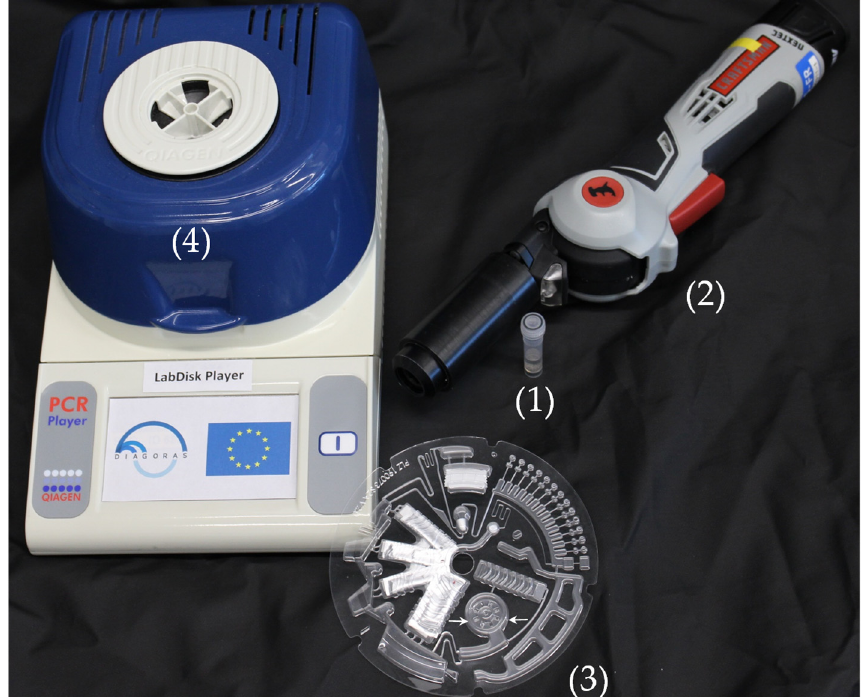
Figure 2. OralDisk design. Blue sector: magnetic bead-based extraction and purification of DNA. #1: sample inlet; #2: stickpacks for storage of buffers for: binding (2a), 1st washing (2b), 2nd washing (2c) and elution (2d); #3: pre-stored (air-dried) magnetic beads; #4: chambers for binding (4a), washing (4b, 4c) and elution of DNA from magnetic beads (4d). Grey sector: eluate transfer module, automating the inward pumping (#5) and eluate mixing with the lyopellet (#6). Red sector: amplification module, automating the preparation and execution of the real-time PCR in structure #7 in the reaction chambers labelled as (i)–(xiii). Structure #8 assists the liquid transfer from chamber #6 to the PCR structure #7.